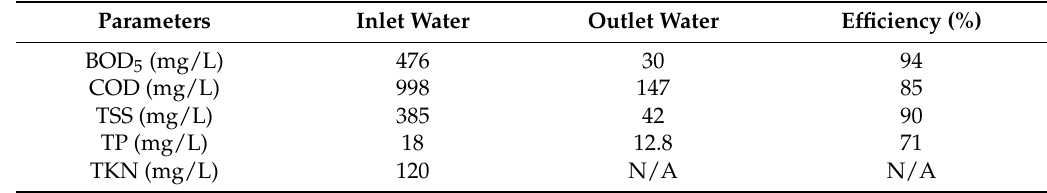
Table 6. Experimental results obtained from the Lefkosa Central Treatment Plant between 2007 and 2008.